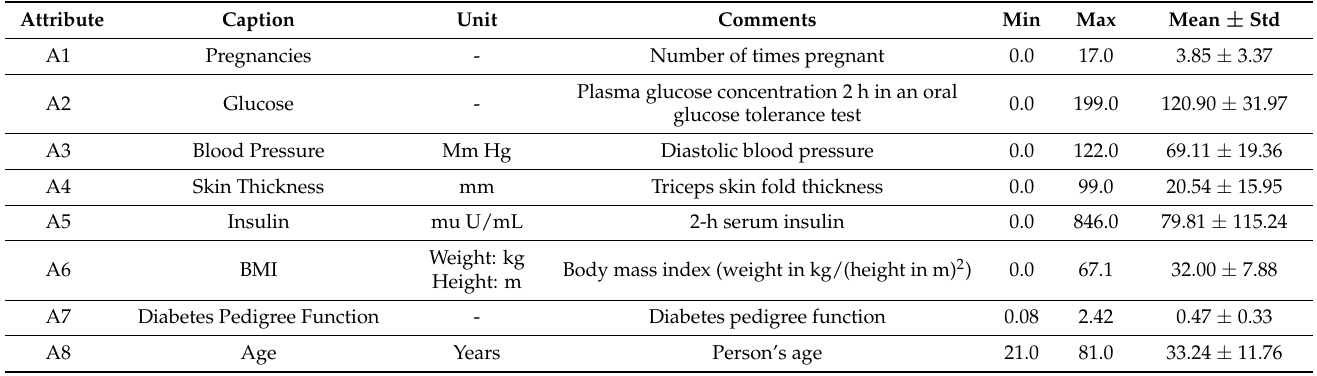
Table 3. A statistical summary of the PIDD.